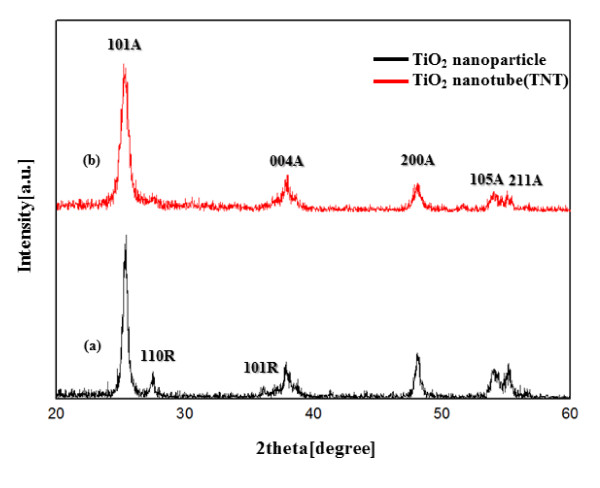
XRD patterns of TiO2 nanoparticles and TNTs.